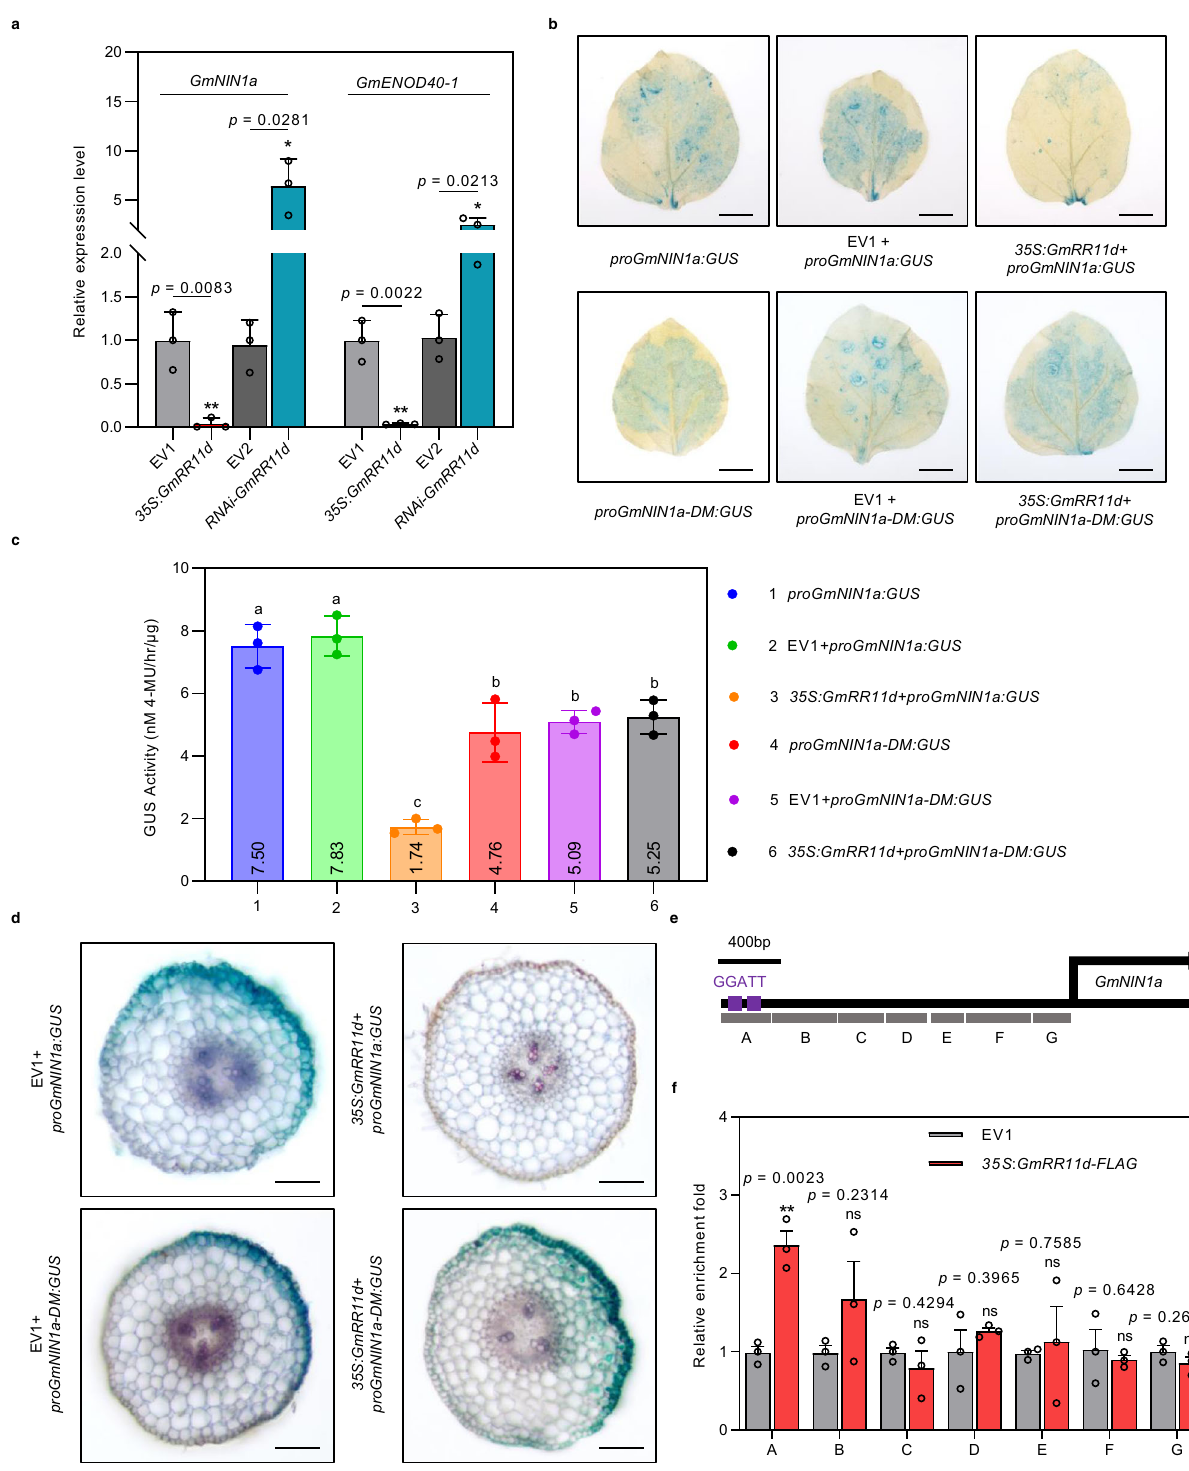
(Fig. 7a, b). The results suggest that rhizobial induction of GmRR11d is likely to be dependent on the function of